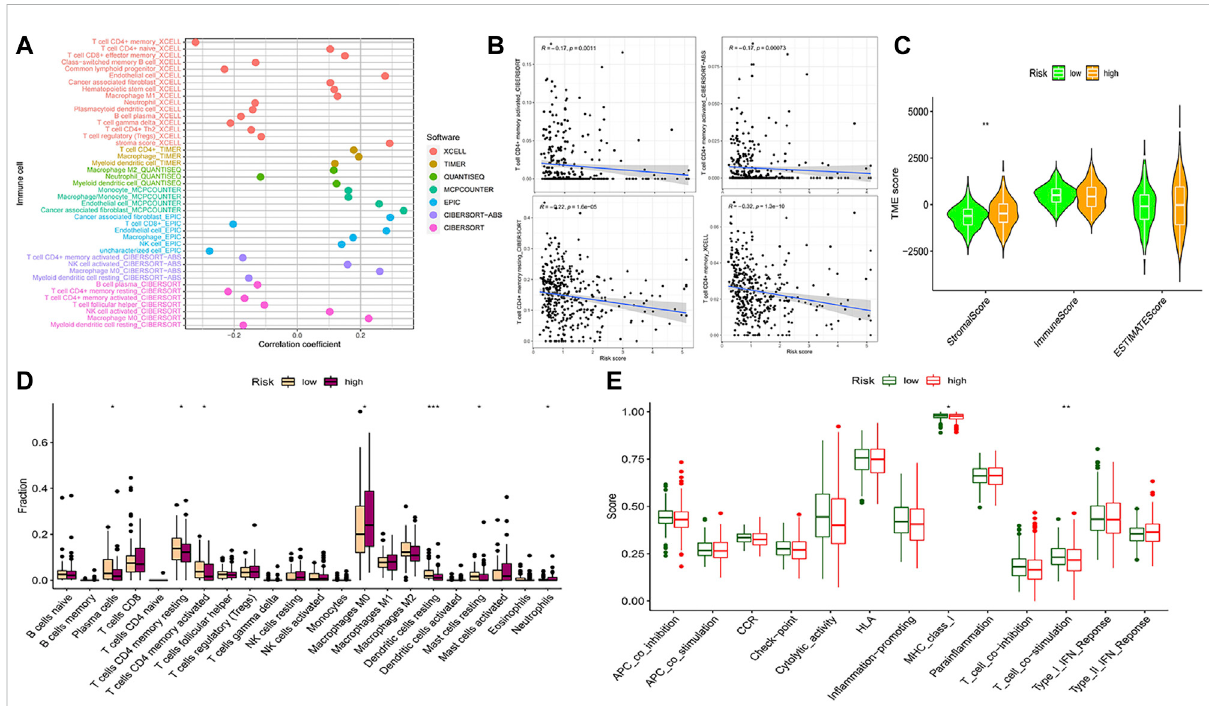
FIGURE 7 Analysis of immune cell in fi ltration and immune cell-related functions. (A) Bubble plot of immune cell in fi ltration related to the risk model was obtained by different software analyses. (B) Scatter plots of the correlation betweenthe hub gene and CD4 + MTC in fi ltration. (C) Violin plot of tumor microenvironment score (** p < 0.001). (D) Differential analysis of immune cell in fi ltration in the prognostic model (* p < 0.05, ** p < 0.01, and*** p < 0.001). (E) Differential analysis of immune cell-related functions in the prognostic model (** p <